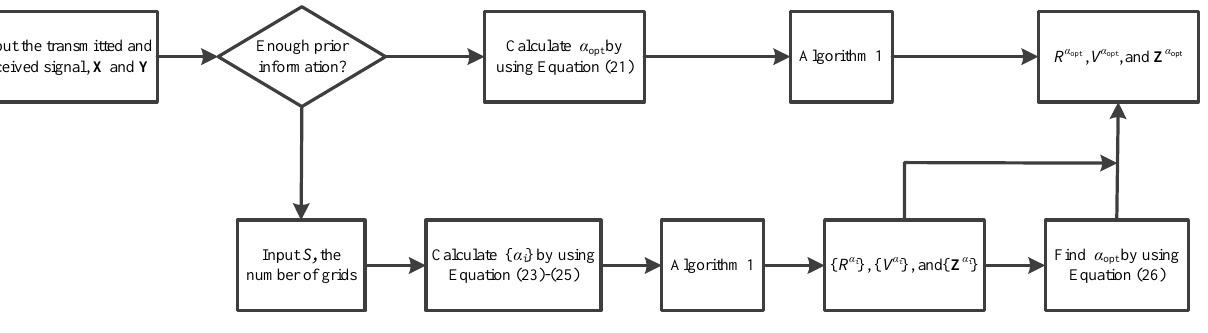
Figure 1. Flow chart of the proposed scheme.